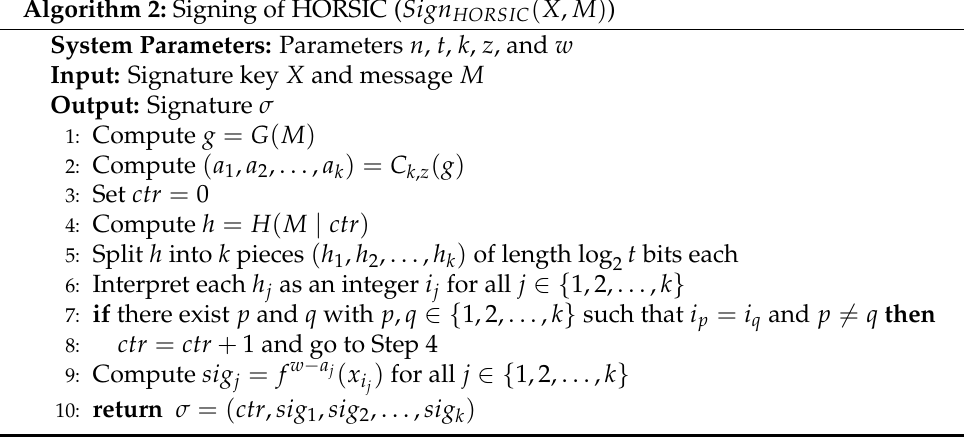
Algorithm 2: Signing of HORSIC ( Sign HORSIC ( X , M ) )